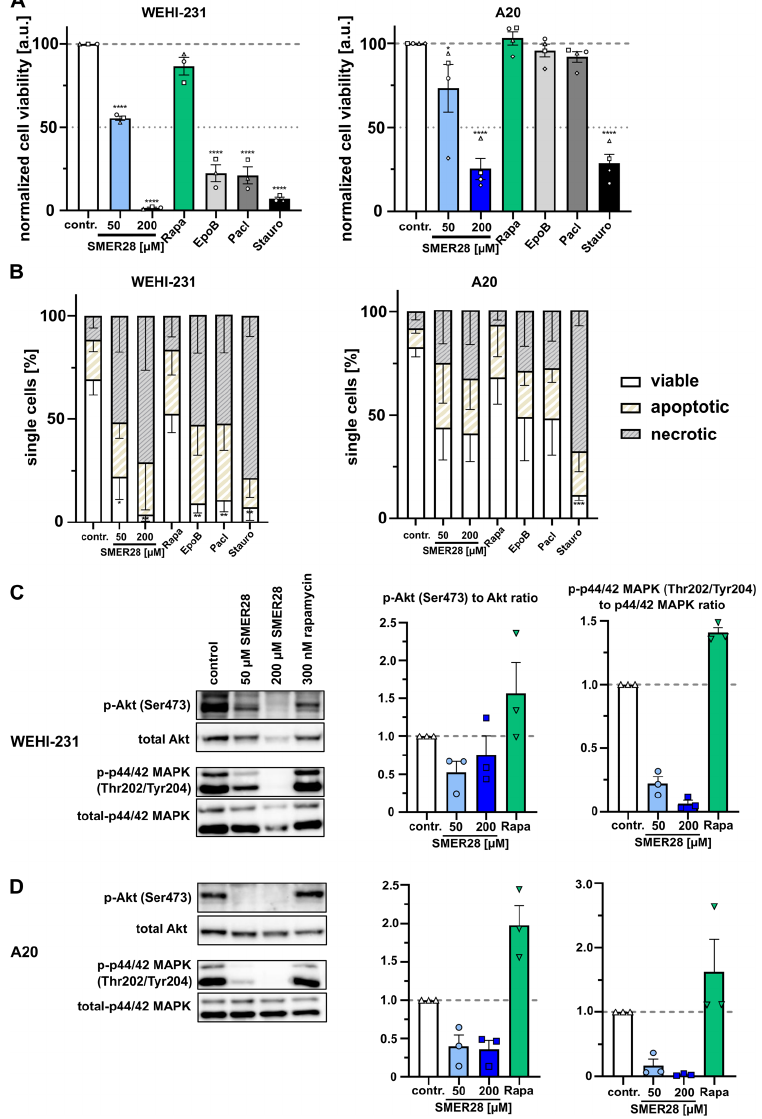
Figure 7. SMER28 reduces B cell viability to different extents. ( A ) Cell viability assay (CellTiter-Glo) of WEHI-231 and A20 cells treated as indicated for 24 h. Graphs show mean cell viability. Data are means ± s.e.m; n = 3. * p < 0.1, **** p < 0.0001, two-way ANOVA. ( B ) Cells were treated as indicated for 24 h, stained with Live/Dead stain and annexin V Alexa Fluor 488 and analyzed by flow cytometry. Cells were categorized as viable versus apoptotic or necrotic. Data were collected from three independent experiments and represent means ± s.e.m. * p < 0.1, ** p < 0.01, *** p < 0.001, **** p < 0.0001, two-way ANOVA. Western blot analysis of WEHI-231 ( C ) and A20 ( D ) cells. Cells were incubated in the presence or absence of 50 or 200 µ M of SMER28 or 300 nM rapamycin, as indicated, for 4 h, lysed in Laemmli buffer and analyzed for levels of phospho-proteins and their respective total proteins. Data are means ± s.e.m. of protein levels derived from three independent